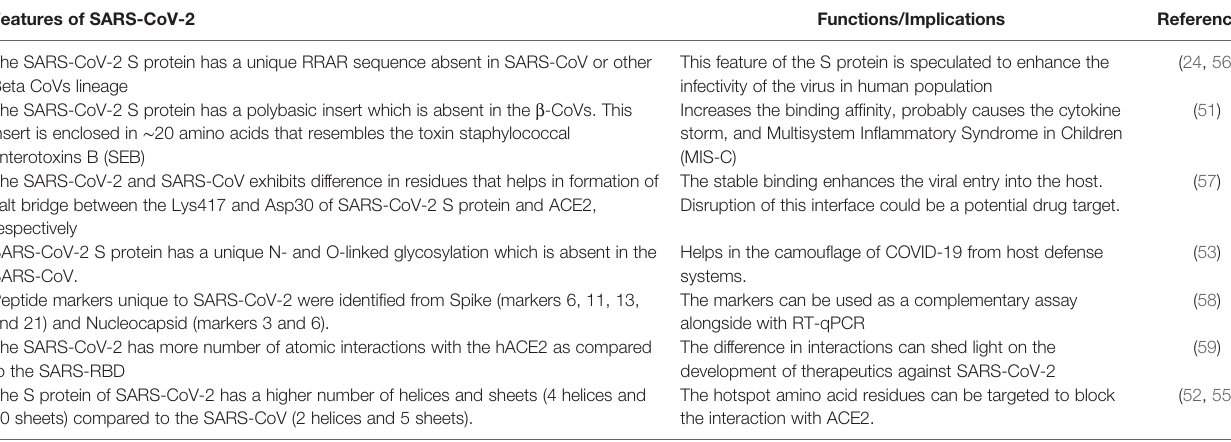
TABLE 1 | Unique features of SARS-CoV-2 S protein and its implications in therapeutic